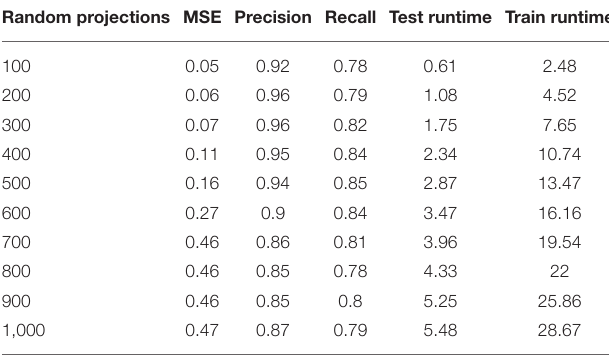
TABLE 2 | Classifiers accuracy for the different classification methods of each attribute selection method.